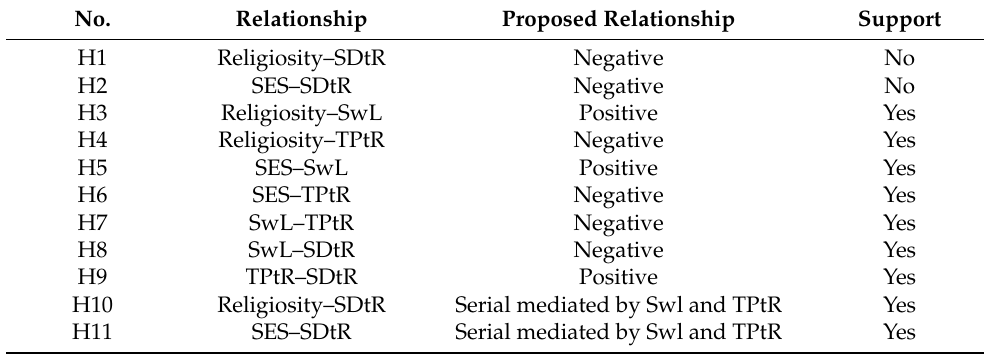
Table 7. Summary of hypothesis testing